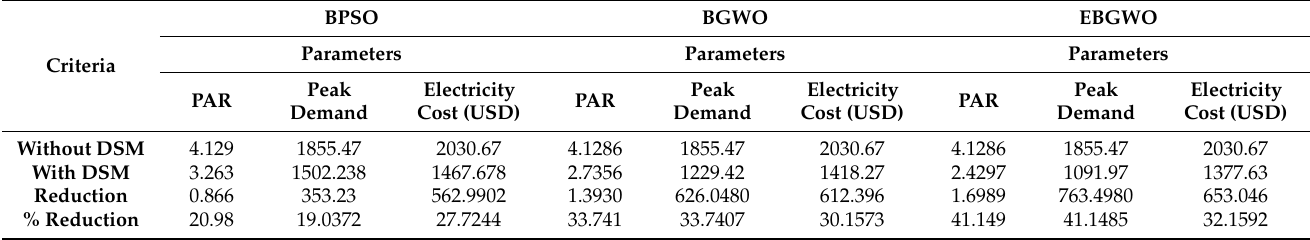
Table 4. Comparison result for before and after implementation of